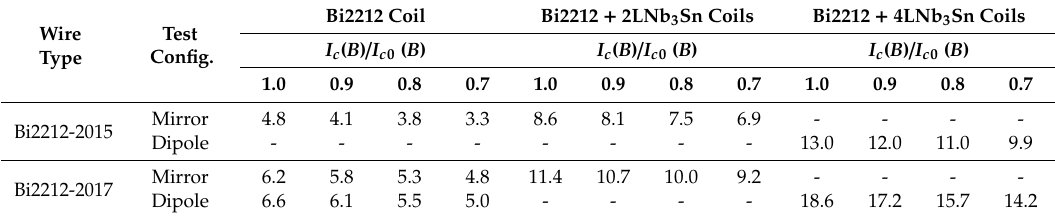
Table 6. Maximum field in Bi2212 coil in various test configurations for two Bi2212 type wires at various levels of I c degradation in coils.